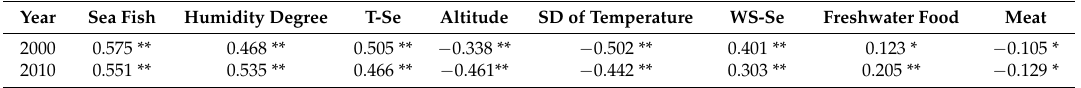
Table 2. Spearman’s correlation coefficients for longevity ratio and each factor. Total selenium (T-Se); water-soluble selenium (WS-Se).